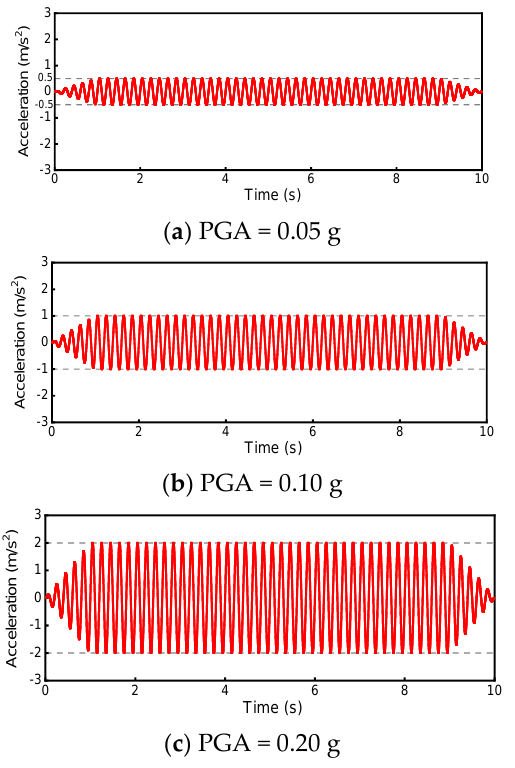
Figure 5. Time-history curves of the input acceleration.